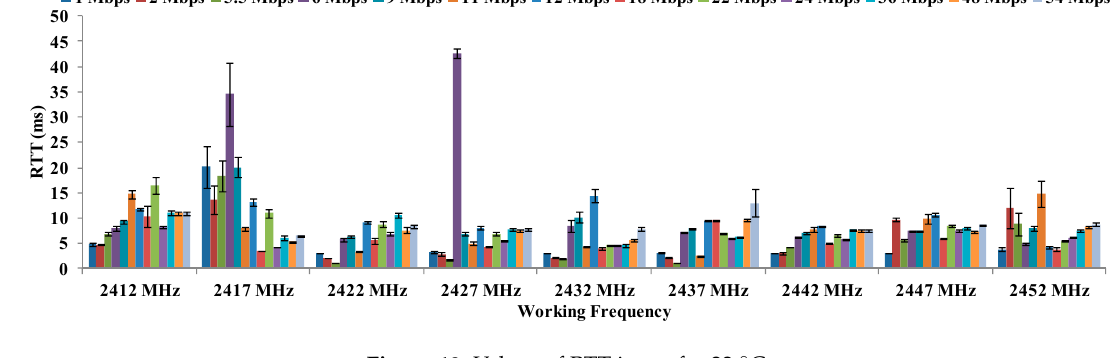
Figure 18. Values of RTT in ms for 22 °C.